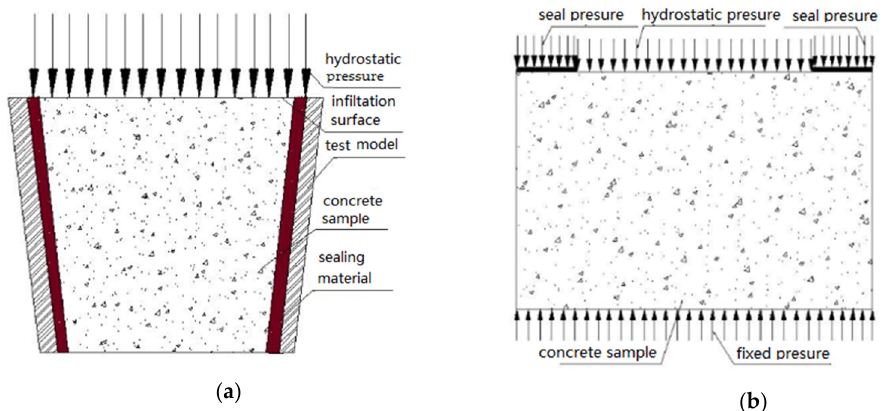
Figure 7. Schematic diagram of the test method of chloride diffusion under hydrostatic pressure. ( a ) Concrete impermeability meter method; ( b ) Test method in this paper.